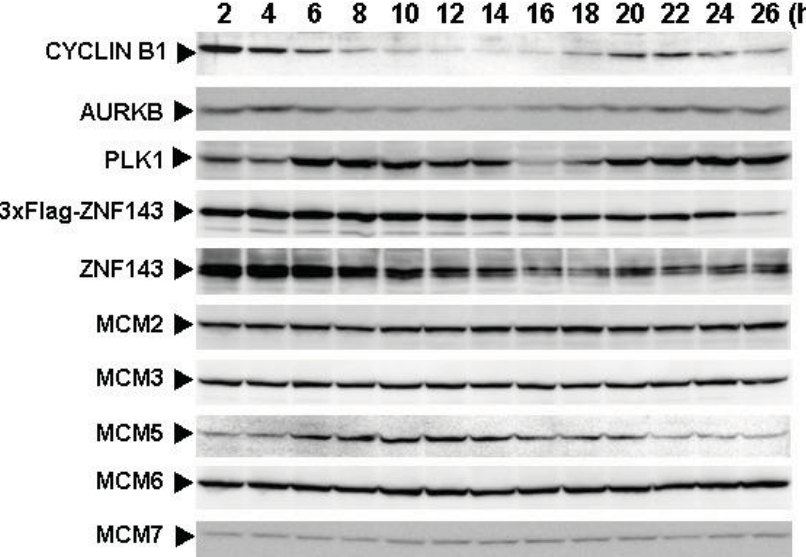
Figure 4. Fluctuations of protein expression associated with the cell cycle in PC3 cells with forced expression of ZNF143. PC3 cells with forced expression of 3xFlag-ZNF143 were cultured for 24 h in serum-free medium and then re-seeded. At the indicated times after re-seeding, cells were collected and fractionated into nucleoplasm and cytoplasm. Each nuclear protein (10 0 μg) was used for Western blotting with the indicated antibodies.